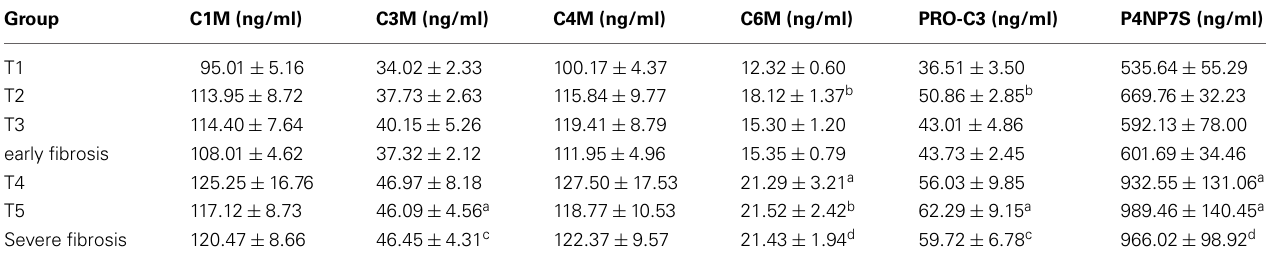
Table 3 | Levels of ECM markers in blood.